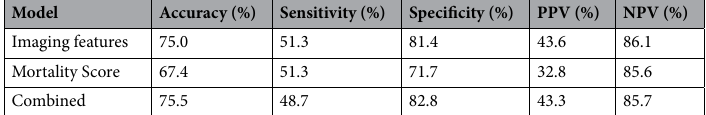
Table 1. Binary classification performances of the proposed models on the testing